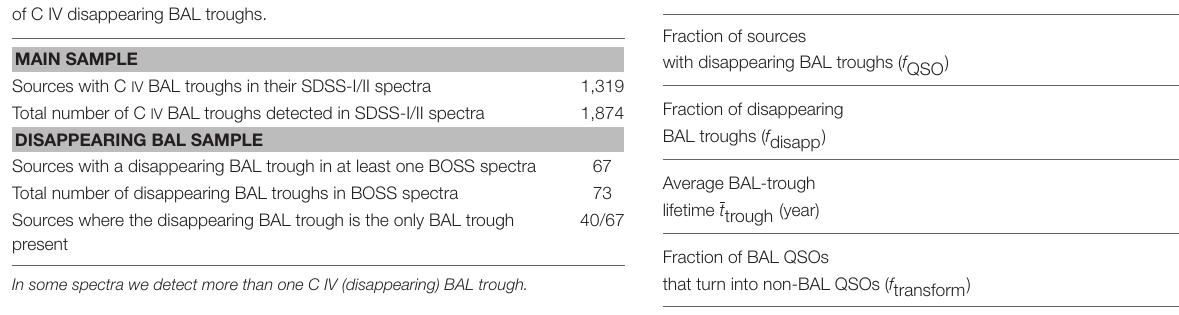
TABLE 2 | Summary of our main numerical